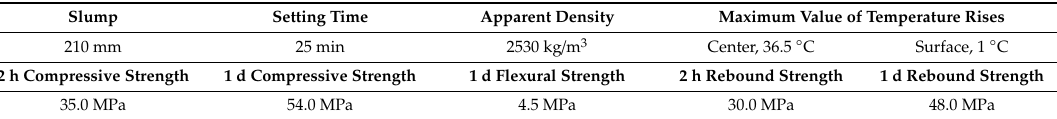
Table 5. The physical and mechanical properties of the MPCC.